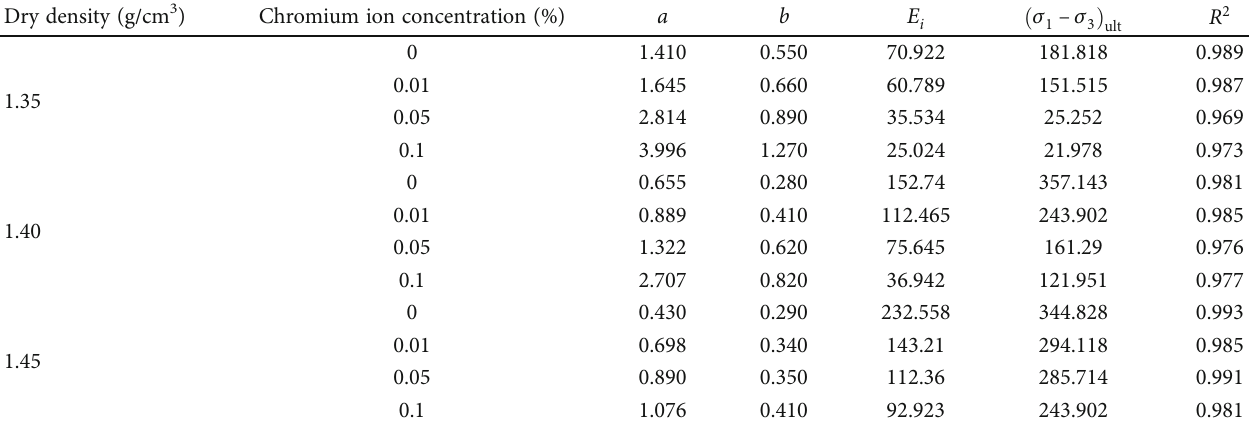
Table 7: Hyperbolic fi tting parameter table of di ff erent dry densities and con fi ning pressures of 300 kPa ( a × 10 − 2 , b × 10 − 2 ). Dry density (g/cm 3 )